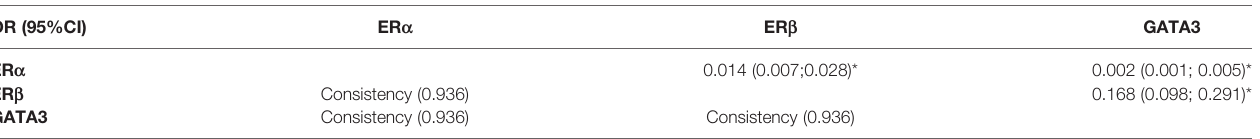
TABLE 5 | Network meta-analysis summary table.